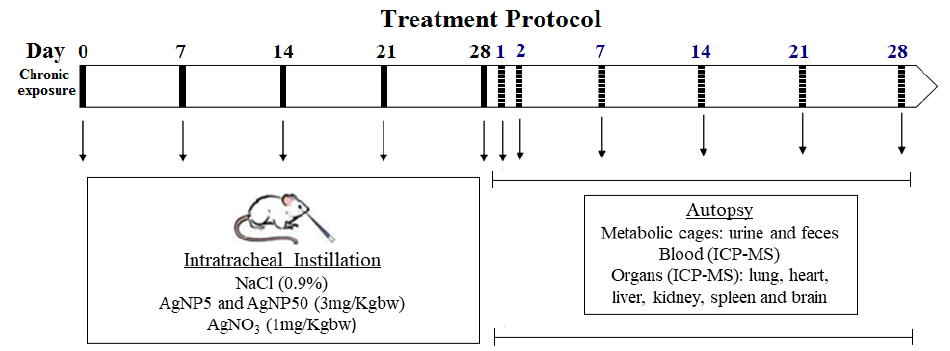
Figure 1. Schematic overview of the experimental protocol. Black lines mean exposure time and dashed lines mean recovery time.